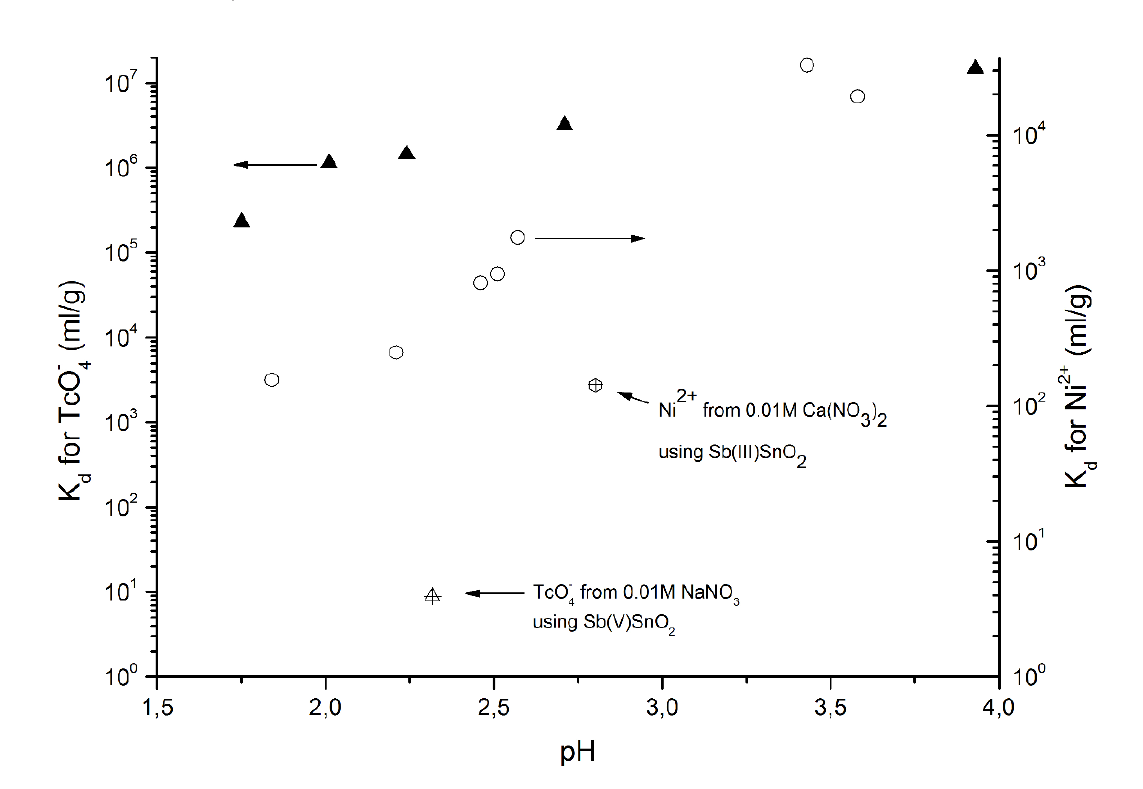
Figure 3. Distribution coefficients (K TcO 4- from 0.01 M NaNO were 42 at pH 2.8 and 1 at pH 2.9,